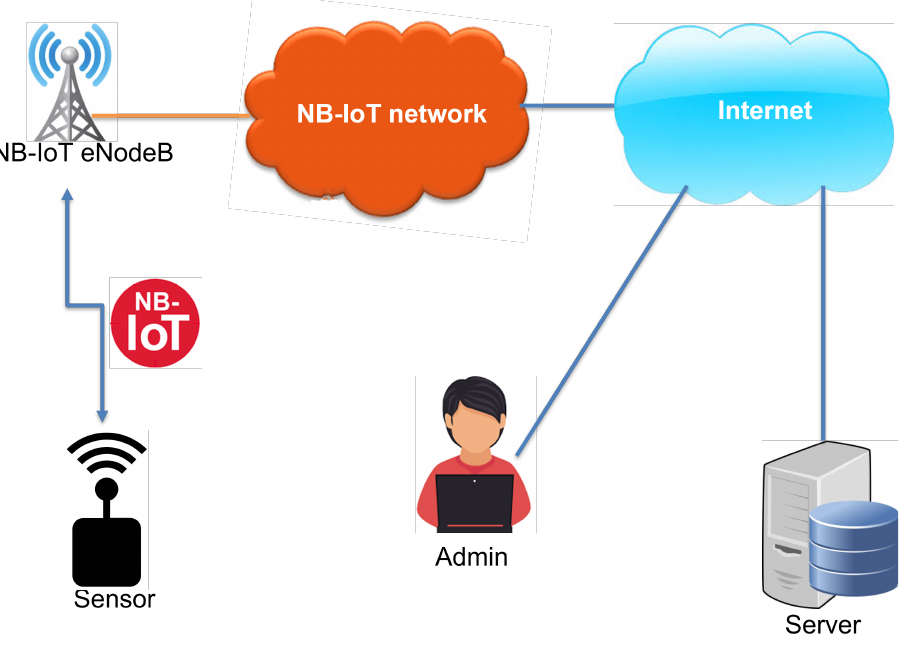
Figure 1. Network